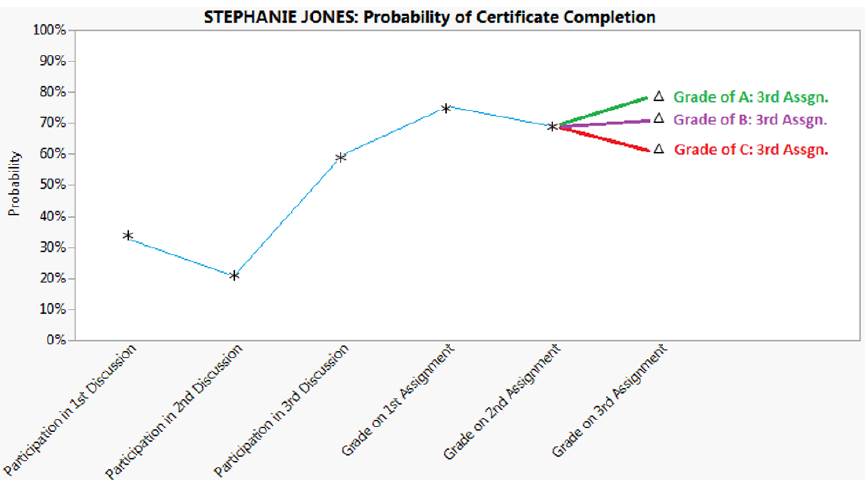
Figure 4. An example of longitudinal, reactive messages.